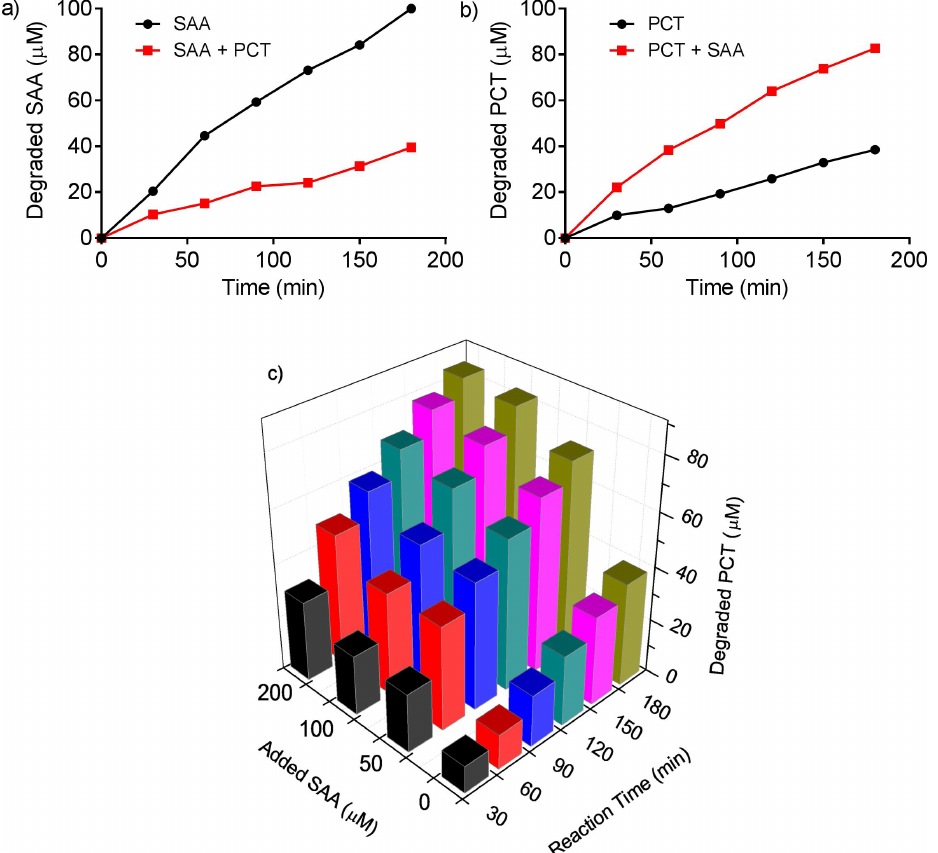
-mediated photodegradation of salicylic acid (SAA) and paracetamol (PCT). (a) Photodegradation of SAA Figure 3. Simultaneous TiO 2 in the absence (black line) and presence (red line) of PCT. (b) Photodegradation of PCT in the absence (black line) and presence of SAA (red line). (c) Photodegradation of PCT in the presence of an increasing concentration of SAA. Reactions catalyzed by TiO the aqueous medium (25 mL) at